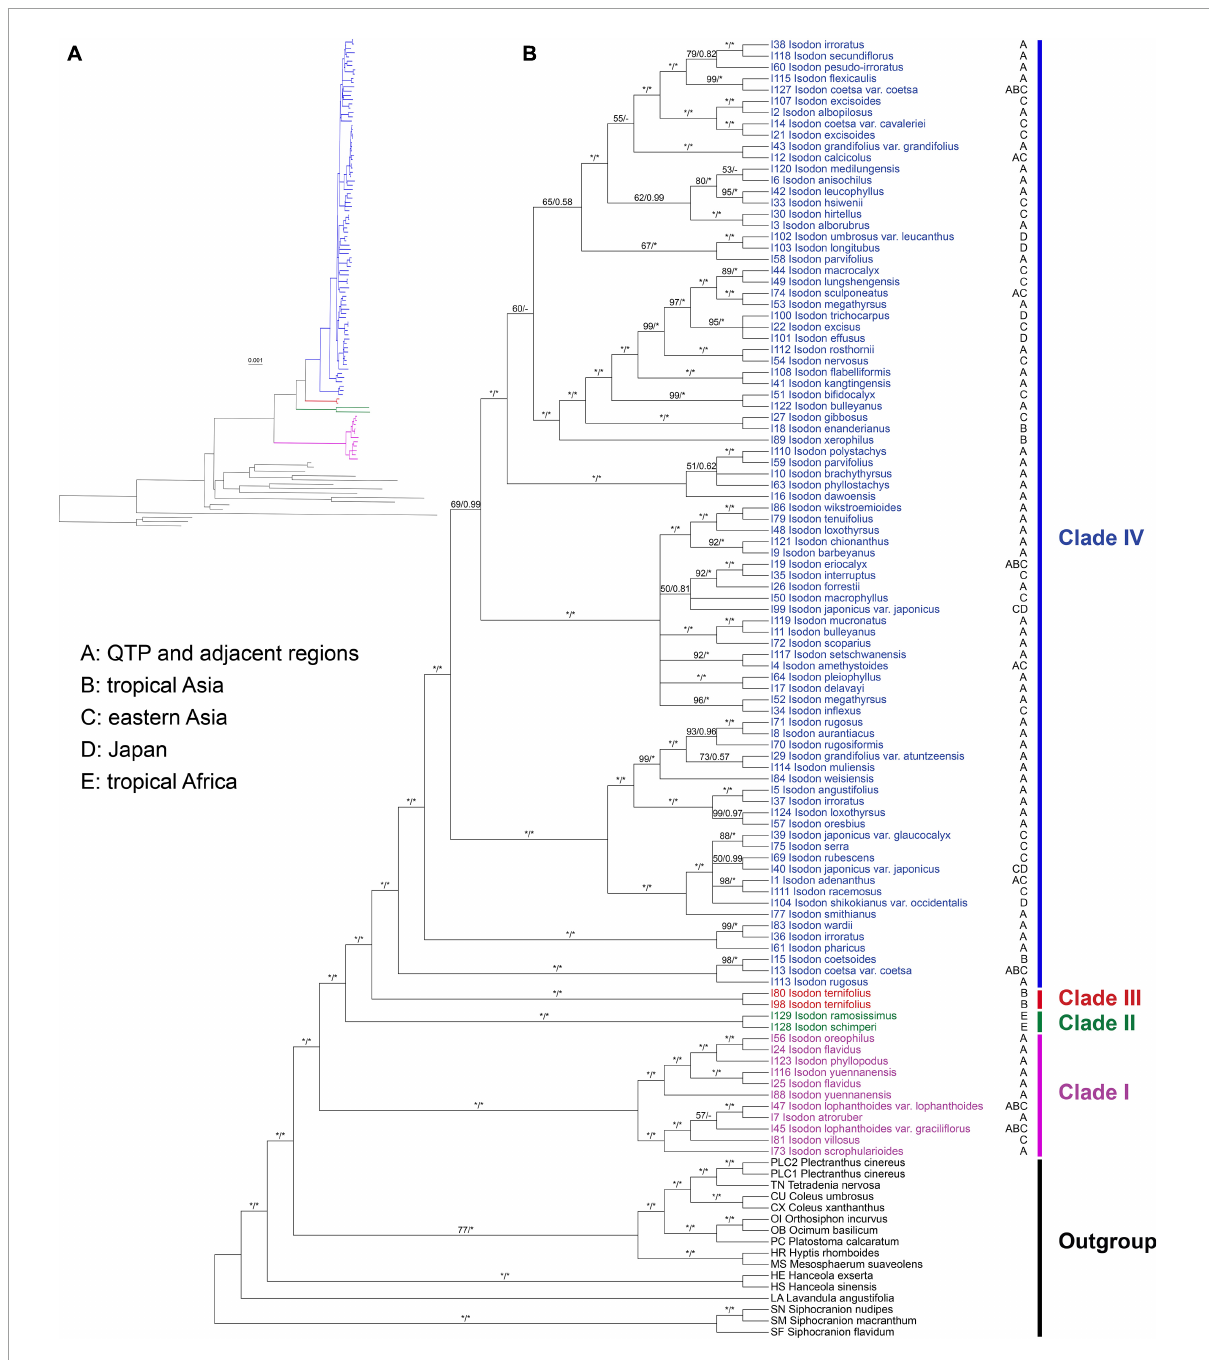
FIGURE1 Cladogram (A) and phylogram (B) of the maximum-likelihood tree of Isodon derived from the plastid phylogenomic analysis of a concatenated data set including 80 coding and 127 non-coding loci with ambiguously aligned regions removed (CR + NCR-GB data set). Support values ≥ 50% BS or 0.50 PP are displayed above the branches (“*” indicates a support value = 100% BS or 1.00 PP, “–” indicates a support value < 0.50 PP). The distribution area(s) of each Isodon species is shown beside the tip and letters coding for areas follow Yu et al. (2014).